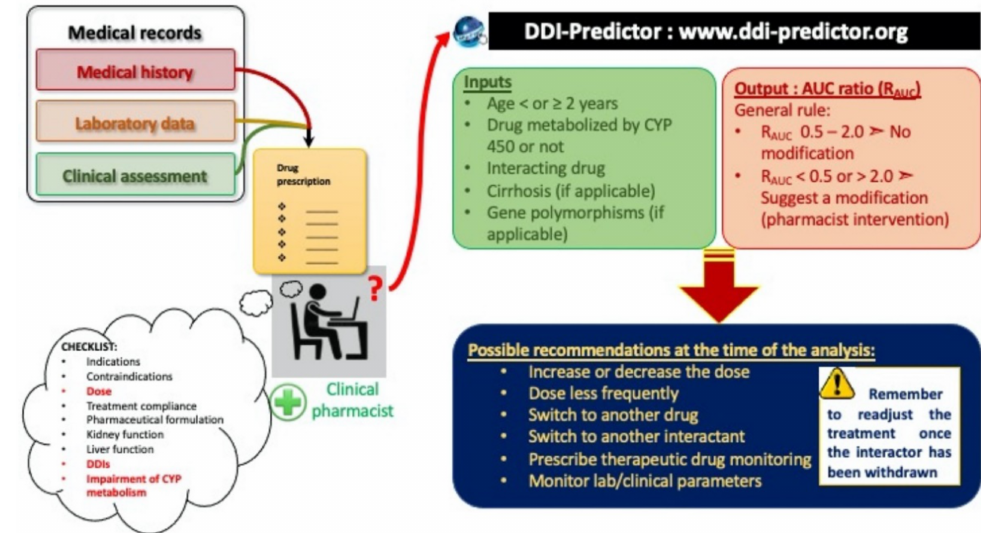
Figure 2. The DDI screening